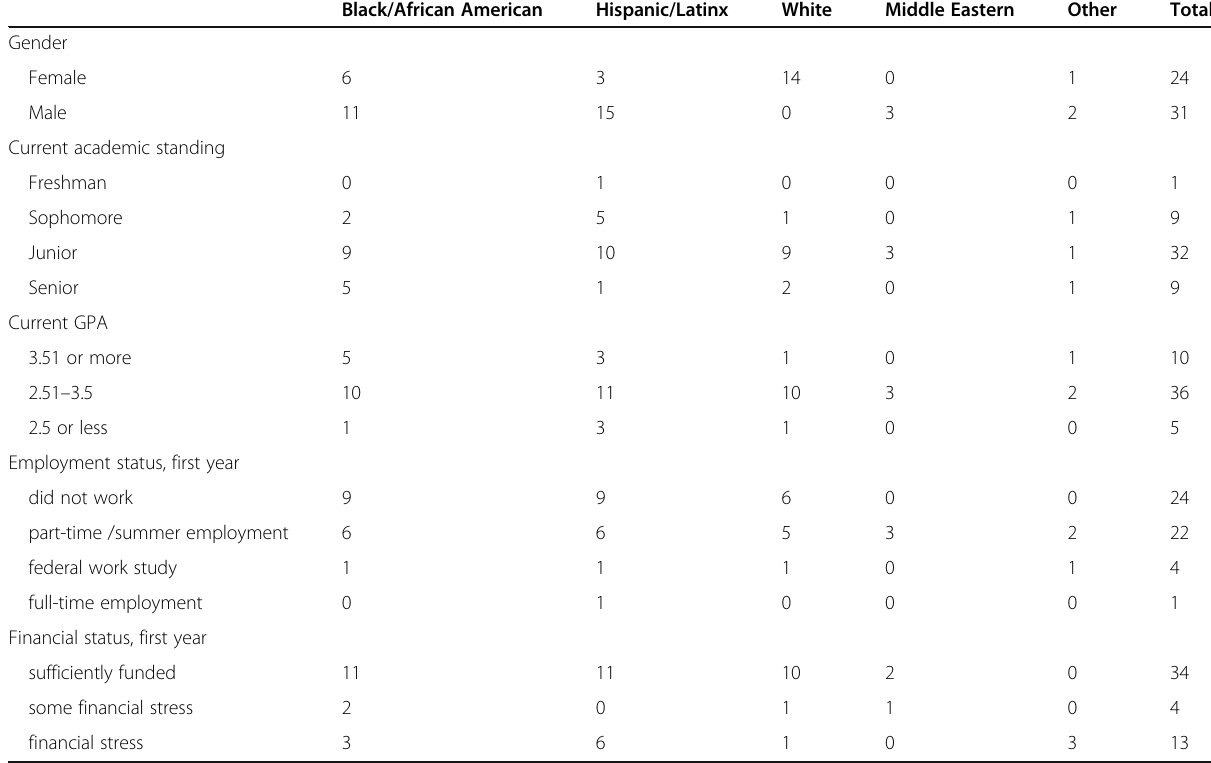
Table 1 Characteristics of interviewed students by